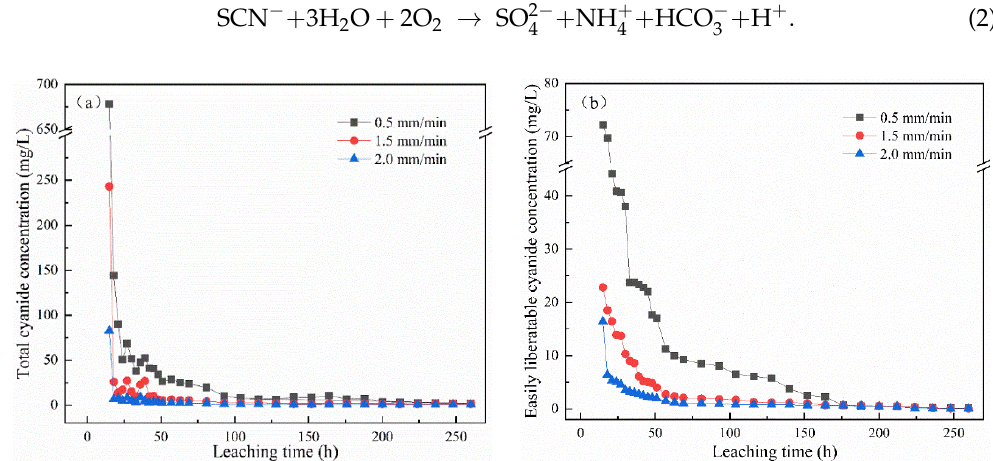
Figure 2. Effect of leaching intensity on the concentration of ( a ) total cyanide and ( b ) easily liberatable cyanide at different timepoints.